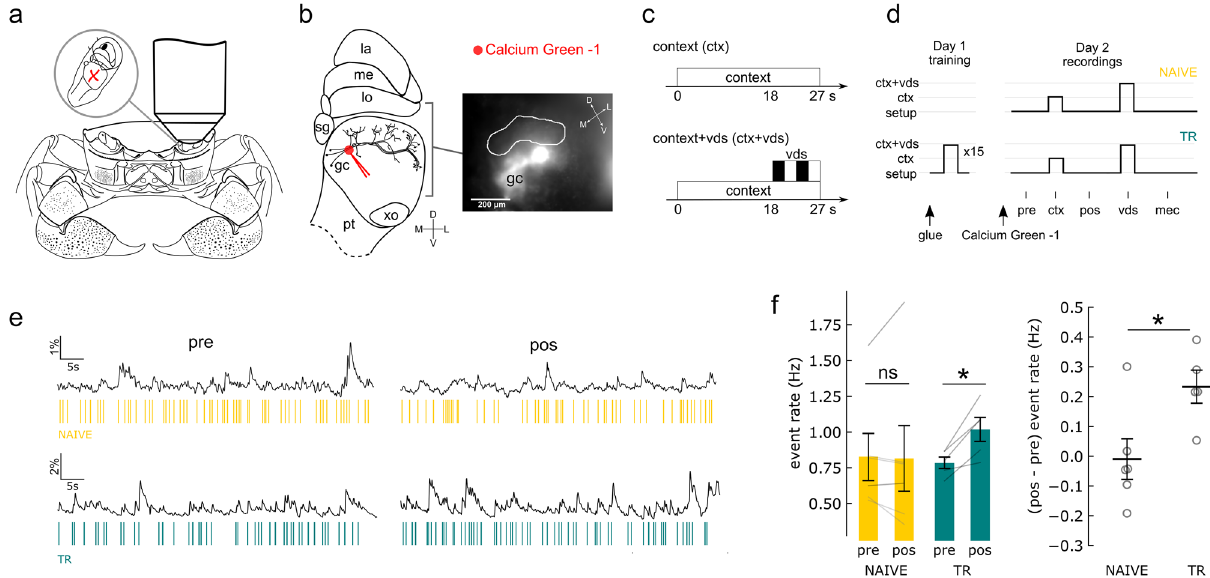
Figure 1. Presentation of the training context induced an increase in the Ca 2+ event rate in crabs trained 24 h before. ( a ), Neohelice granulata crab and detail of the left eyestalk. The mushroom body-like structure (MB-ls) is in the lateral protocerebrum (marked with a red cross). Fluorescence recordings were done in the left eyestalk. ( b ), Left, frontal view of neuropils in the eyestalk. For in vivo Ca 2+ imaging, a window was opened in the left eyestalk and a calcium sensitive dye (Calcium Green-1 dextran) was inserted in the tract of the MB-ls globuli cells. Right, example of the preparation view under the microscope. The bright spot corresponds to the place where the dye crystals were stabbed. Orientation references match an upright eyestalk position. The region of interest (ROI) is delimited. ( c ), Context and vds trials scheme. Context presentation involves a phasic change in setup illumination. The visual danger stimulus (vds) is presented during the last nine seconds of a 27 s context presentation and comprises a black rectangular panel moving over the horizon of the crab back and forth twice in each trial (vds, black bars). ( d ), Experimental protocol. On day one, crabs have their left eyestalk glued in place ready to be open for recording at day two. Then, they were trained (TR group) under the microscope with of the vds over the crab’s right eyestalk (15 trials, ISI 3 min). Naive group (NAIVE) was not trained. Each visual stimulus was preceded by the onset of the context (see “c”). On day two, Calcium Green -1 dextran was inserted and several recordings at different periods were done. Recordings involved periods of no stimulation (pre, pos) and trials with context, visual or mechanical stimulation (ctx, vds and mec). ( e ), Examples of ΔF/F (%) obtained during pre and pos context presentation periods for a NAIVE (above) and TR (below) animal. Ticks below each curve correspond to Ca 2+ events. ( f ), Event rate (Hz) for NAIVE and TR animals during pre and pos periods (left) and difference between pos and pre period (right). Grey lines and circles correspond to individual animals. Means ± sem are shown. Post hoc Welch two-tailed paired t-tests and independent t-test, * p < 0.05,